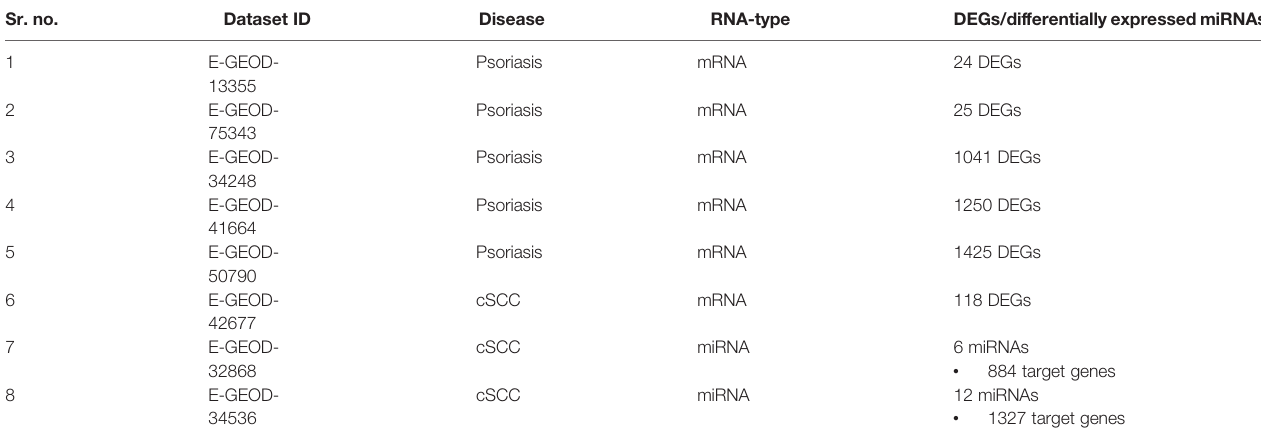
TABLE 2 | Number of identi fi ed DEGs / differentially expressed miRNAs of microarray datasets. Sr. no.